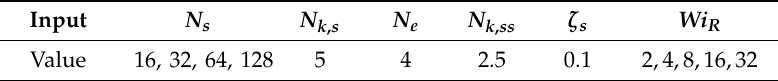
Table 2. Input parameters for slip-spring